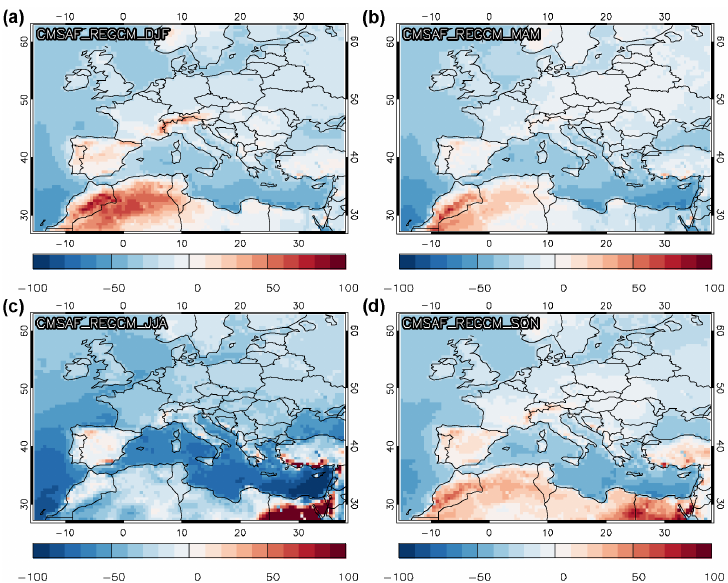
Figure 4. The same as Fig. 1 but for RegCM4 and CM SAF CFC.